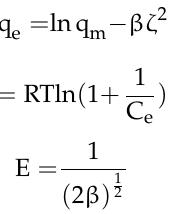
Figure 5. Freundlich isotherms of X zeolite for Cu 2+ ( a ) and Zn 2+ ( b ). The Dubinin-Radushkevich (D − R) isotherm model is generally used to estimate the adsorption mechanism (physical or chemical adsorption) of microporous adsorbents, which was based on the adsorption potential theory. The adsorption potential theory reflected the change in the Gibbs free energy of an adsorbent after adsorbing a unit molar mass of adsorbate. The equation is expressed as follows: